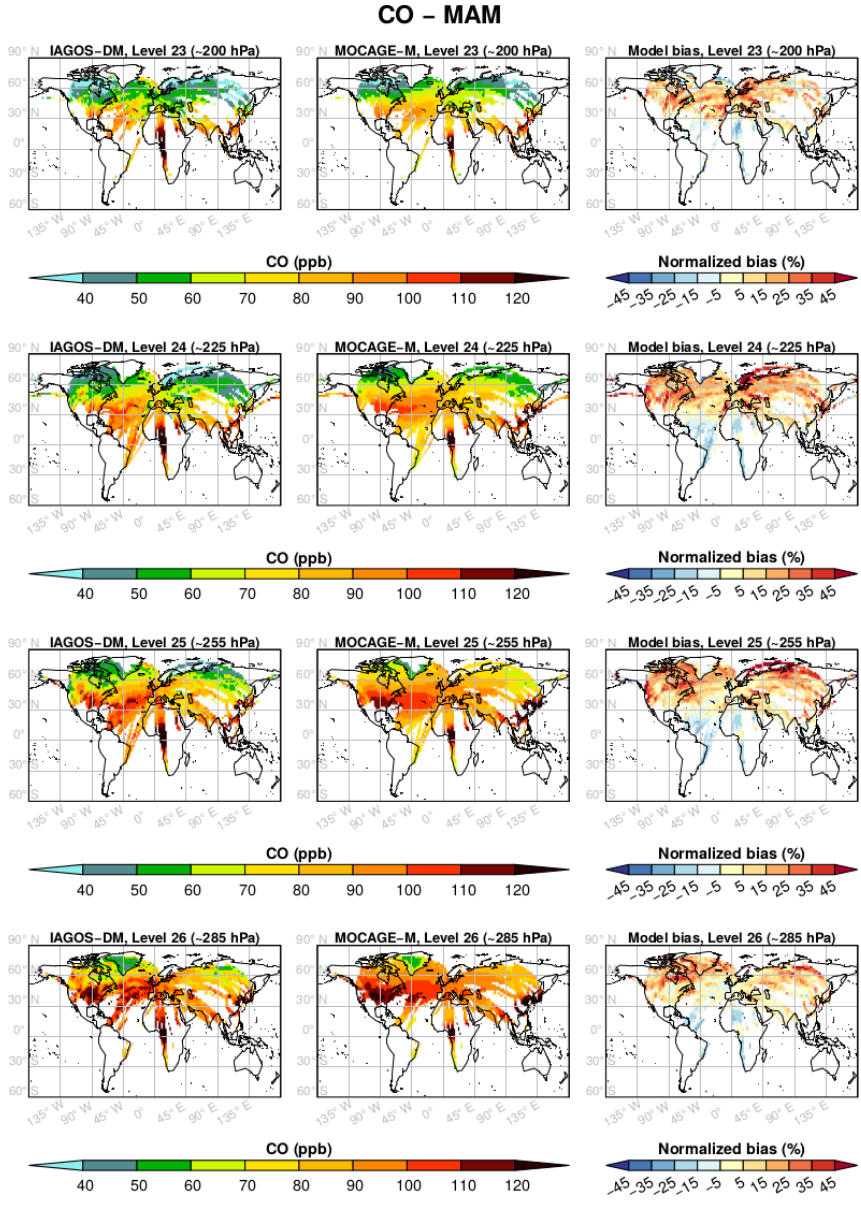
Figure A6. As Fig. 4 for boreal